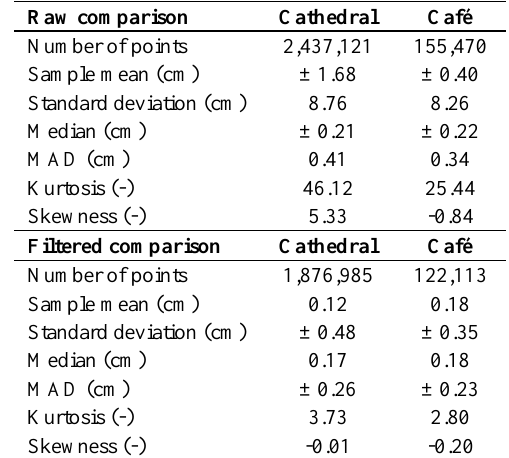
Table 4. Statistical results of the accuracy evaluation: MMS vs. TLS for the square dataset on the raw and filtered point clouds.